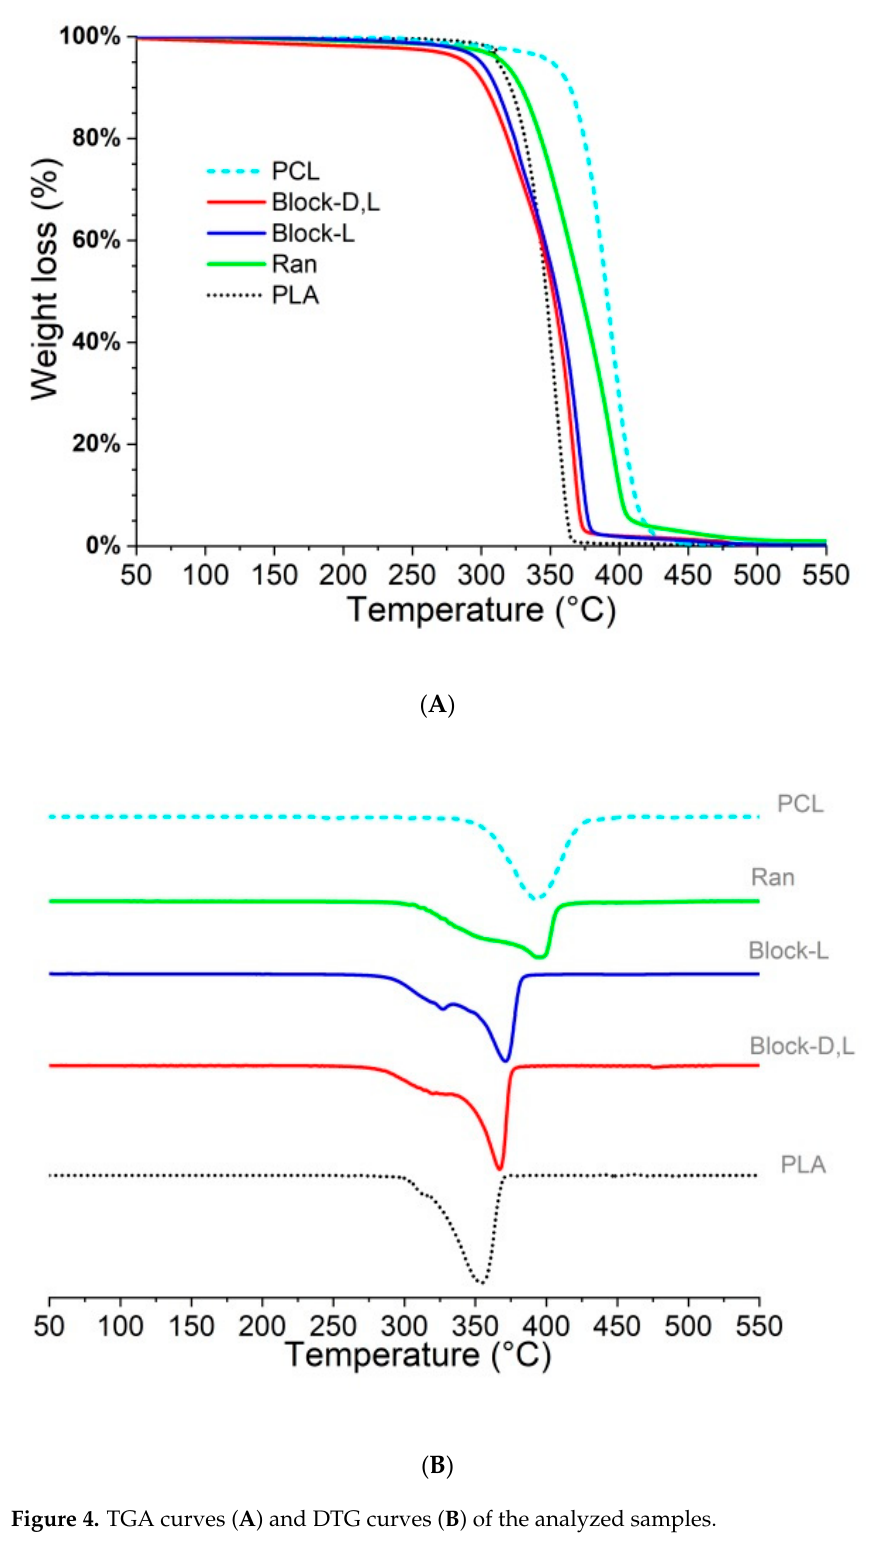
Figure 4. TGA curves ( A ) and DTG curves ( B ) of the analyzed samples. For all samples, the temperatures at 5% mass loss (T5%), the peaks positions (Td1 and Td2) of the DTG curves and the temperature degradation range ( Δ T1 and Δ T2) are summarized in Table 2. In particular, the degradation ranges ( Δ T1 and Δ T2) are calcu- lated as the difference between the peak position temperature (Td1 and Td2) and T5%. At